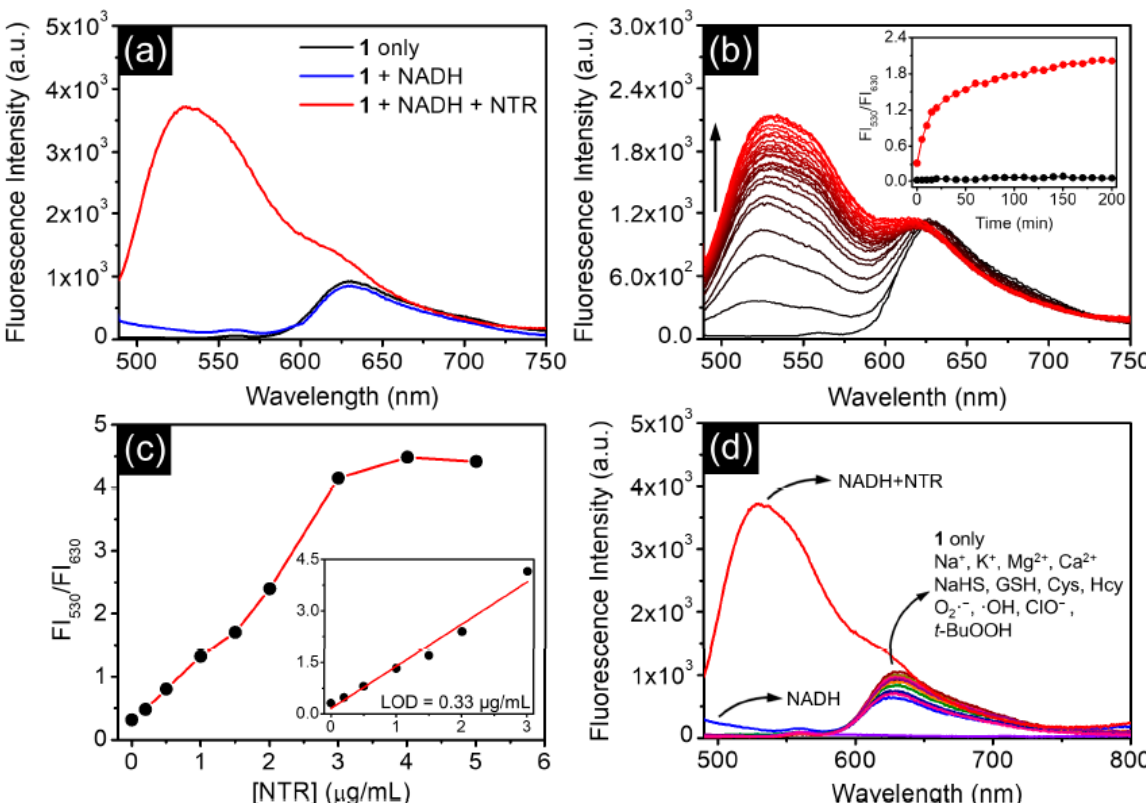
Figure 2. ( a ) Fluorescence spectra of probe 1 (10 µ M) with and without NTR (2.0 µ g/mL) and NADH (300 µ M). ( b ) Time- dependent fluorescence change. Inset: fluorescence intensity ratio vs. time; the black and red lines indicated fluorescence ratio of the probe without and with NTR activity. ( c ) Fluorescence intensity ratio vs. NTR concentrations containing NADH (300 µ M). Inset showed a linear correlation with the NTR concentration in the range of 0–3 µ g/mL. ( d ) Fluorescence responses to NADH (300 µ M), metal ions (1 mM, respectively), thiols (1 mM, respectively), ROS (100 µ M, respectively), and NADH (300 µ M) + NTR (2 µ g/mL). All data were obtained in a PBS buffer (10 mM, pH 7.4)/DMSO (99:1, v/v ) with 90 min incubation at 37 ◦ C. λ ex = 470 nm.